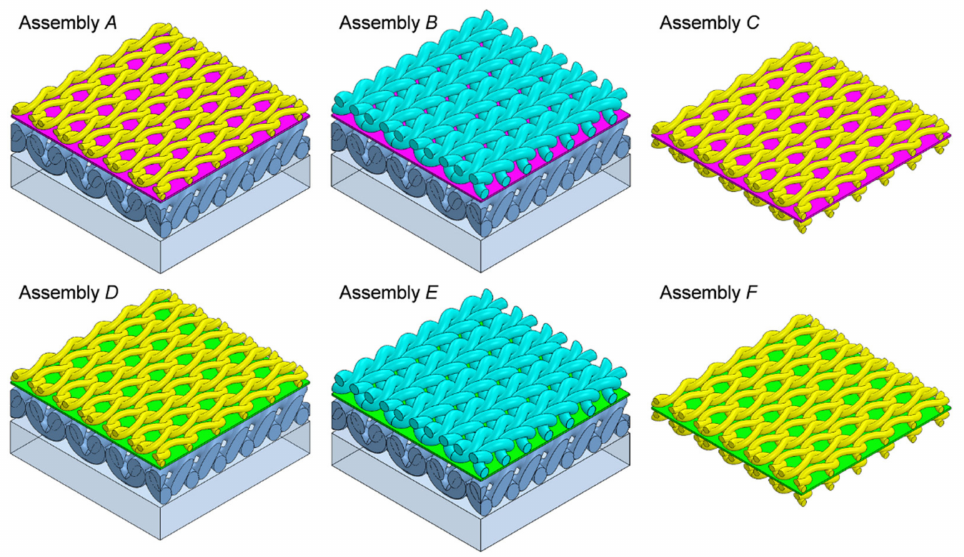
Figure 8. Images of 3D models of six tested